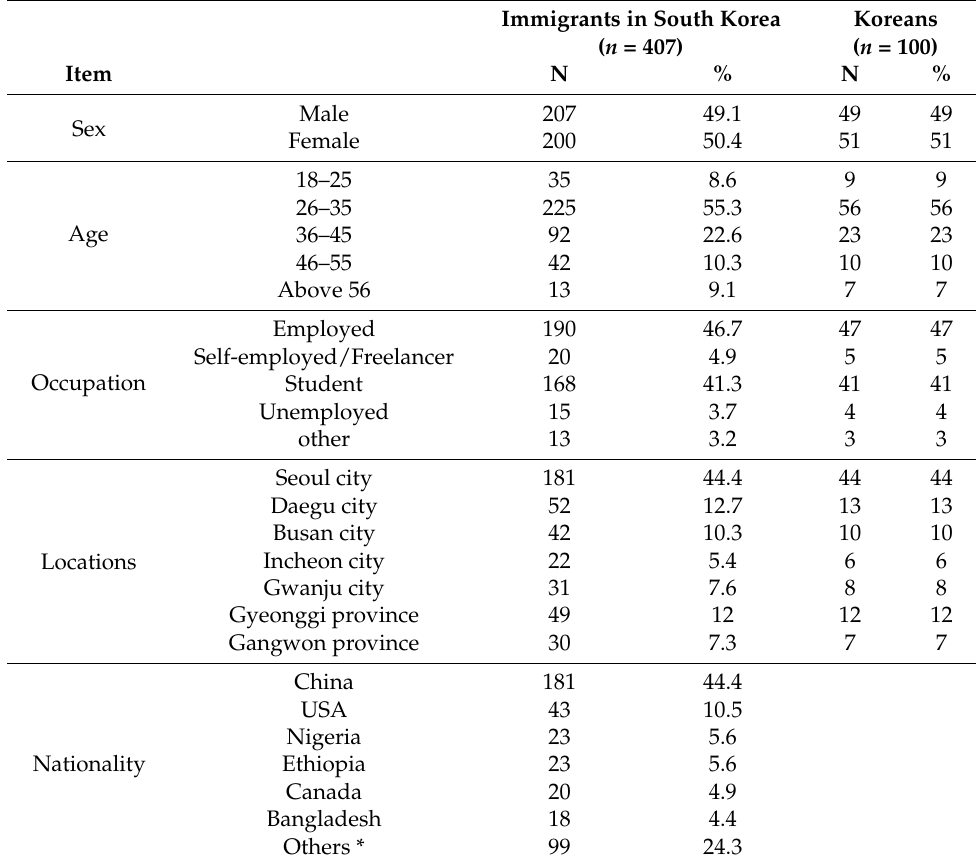
Table 1. Participants